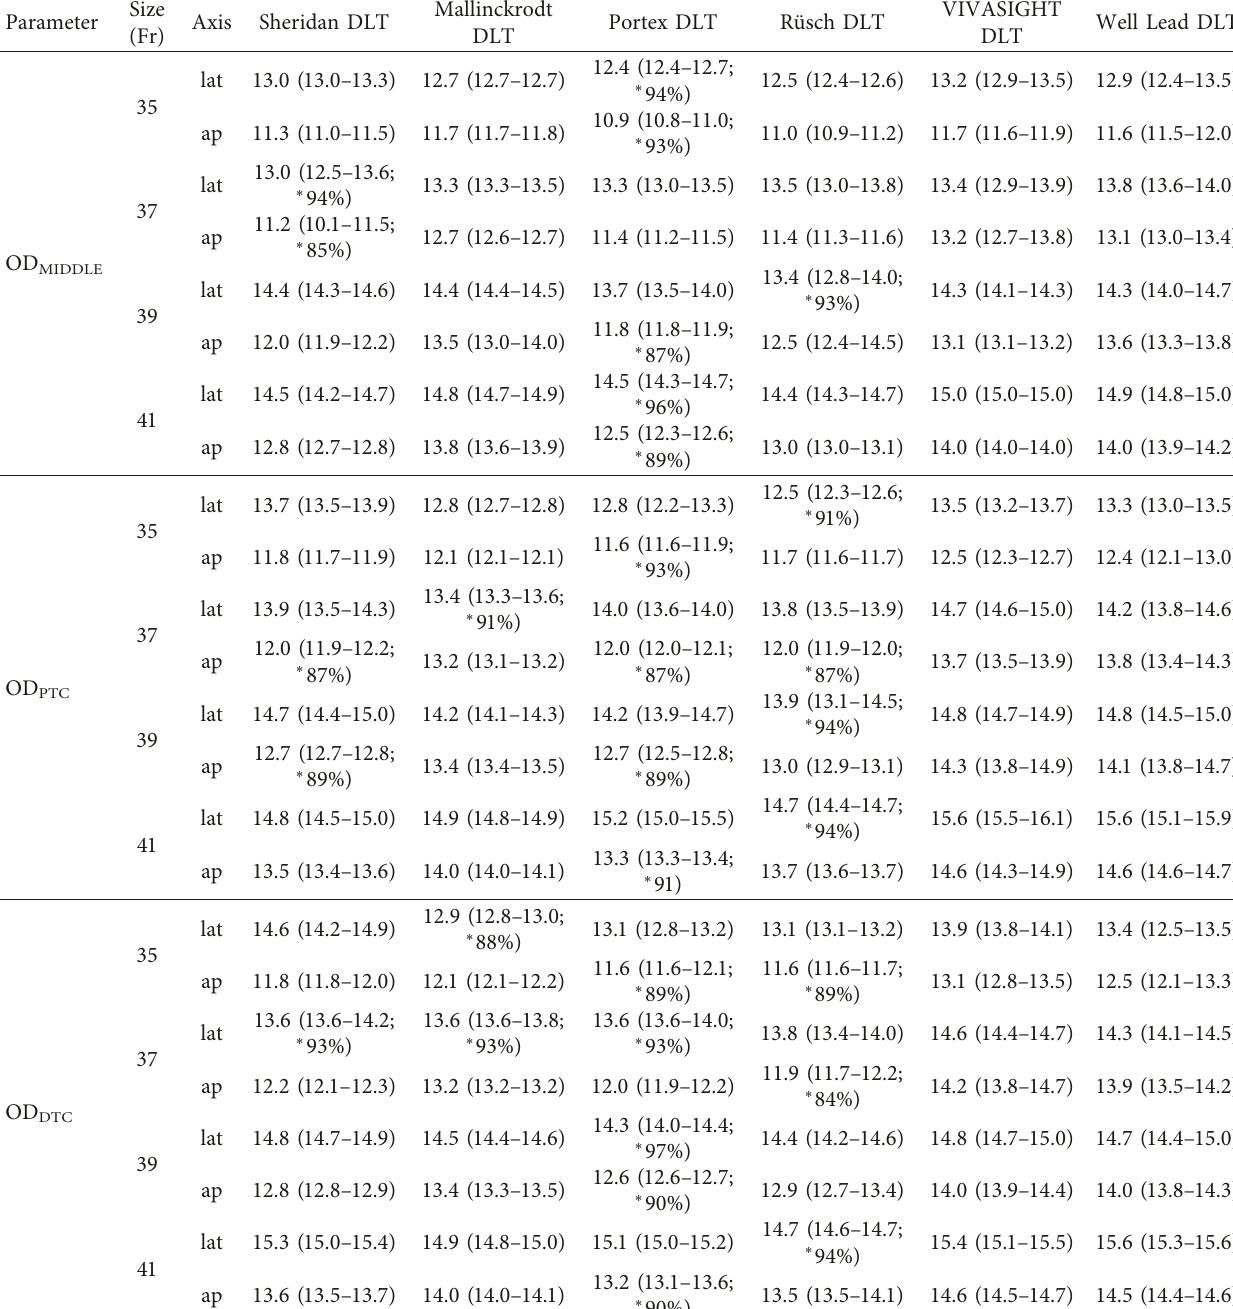
Table 2: Outer diameter (OD), presented as lateral diameter (lat) und antero-posterior diameter (ap) of investigated left-sided double- lumen endobronchial tubes